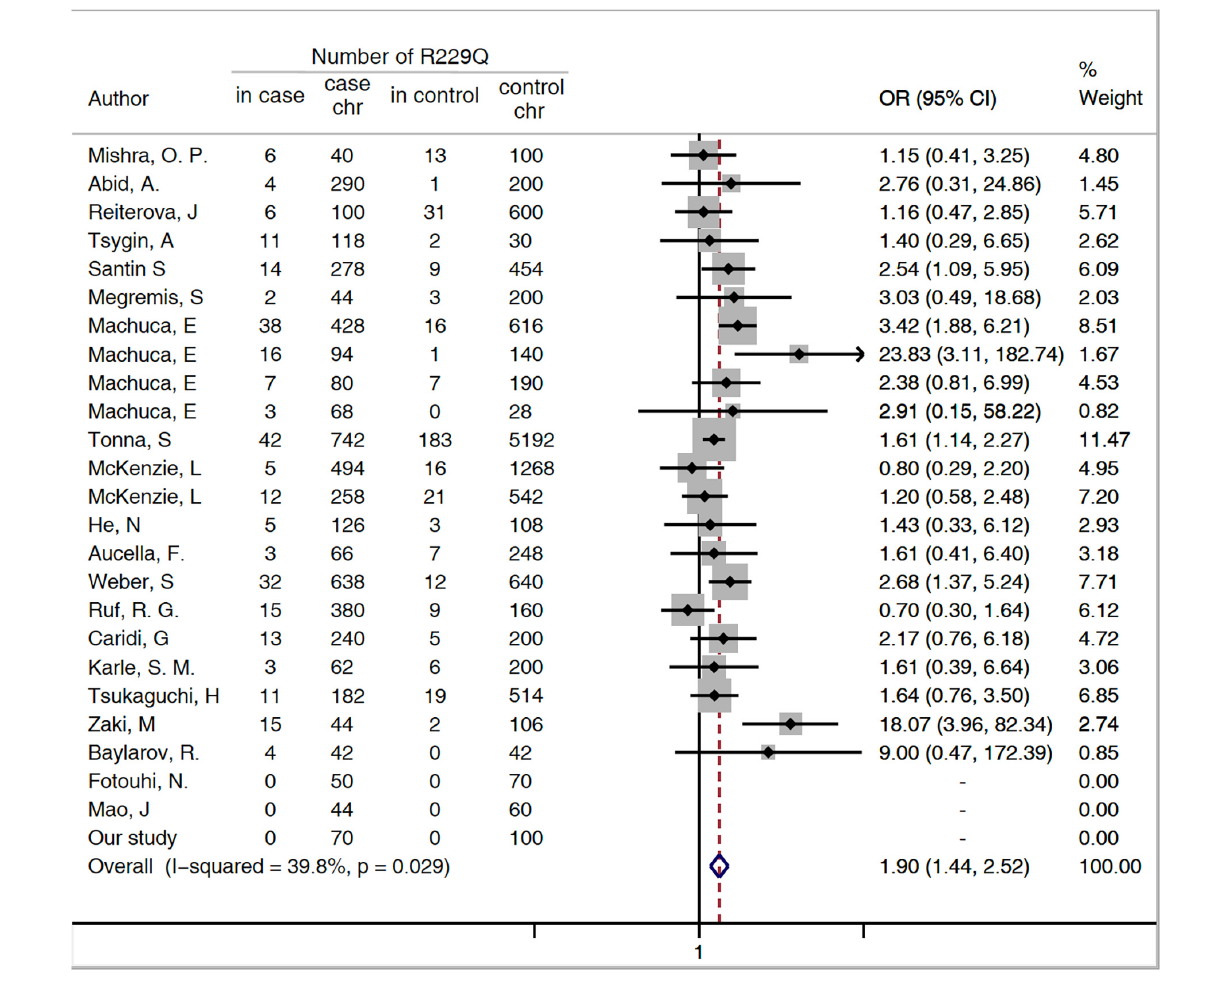
Frontiers in Medicine |